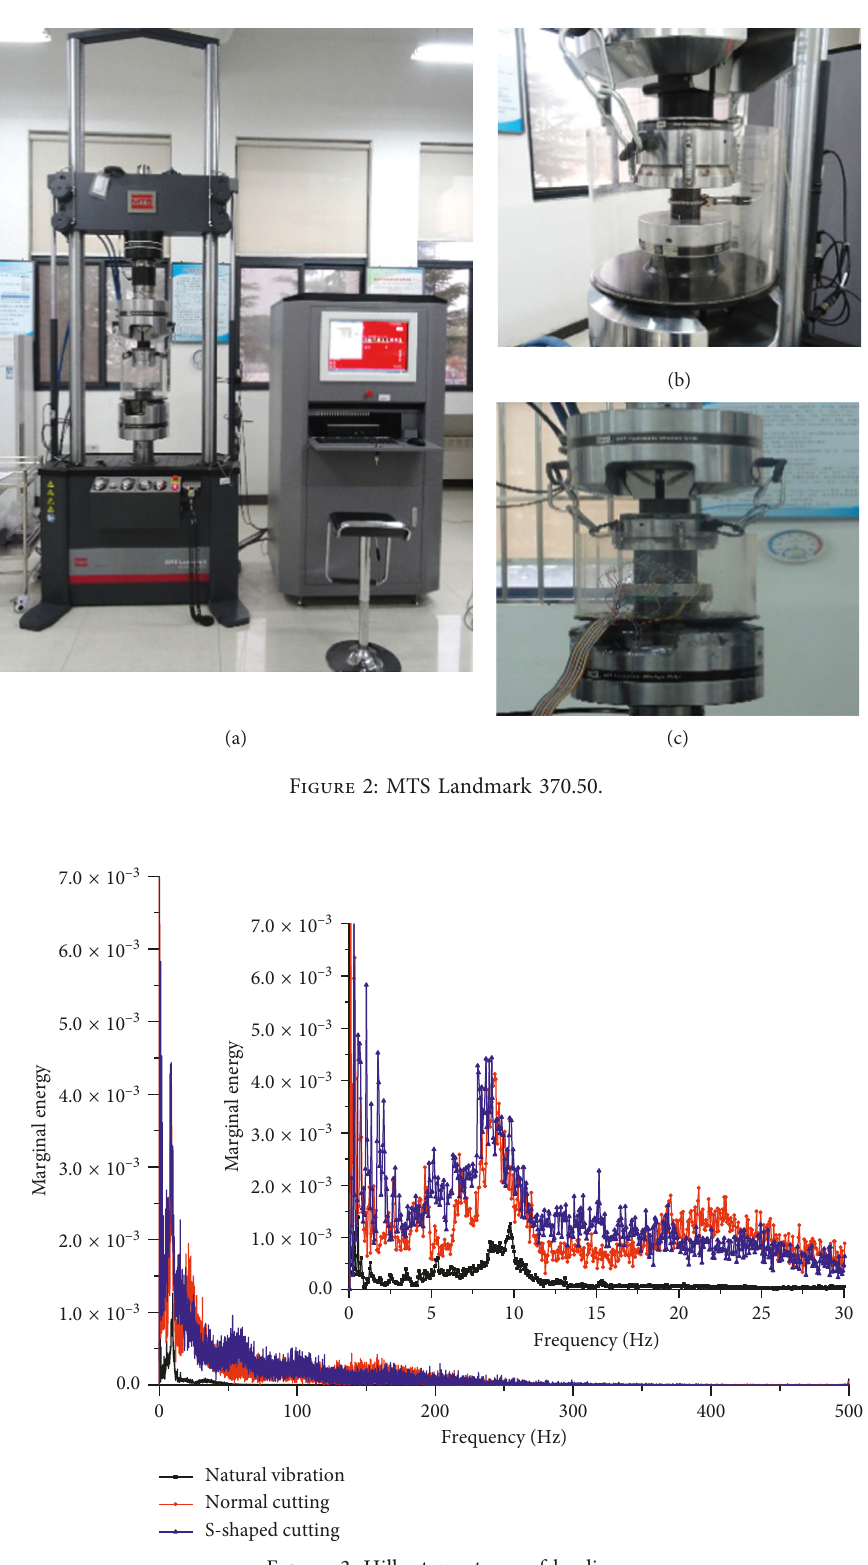
Figure 3: Hilbert spectrum of loading.